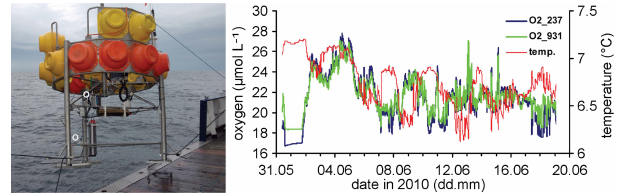
Fig. 3. Left-hand panel: photograph of the GEOMAR benthic ob- servatory. White circles denote oxygen optodes attached 0.3 and 1m (serial numbers 237 and 931, respectively) above the seafloor. Right-hand panel: time series of bottom-water oxygen concentra- tion and temperature measured 0.3m (blue line) and 1m (green line) above the seafloor at a 90m-deep station in the Gotland Basin dur- ing summer 2010 (Alkor cruise AL355).